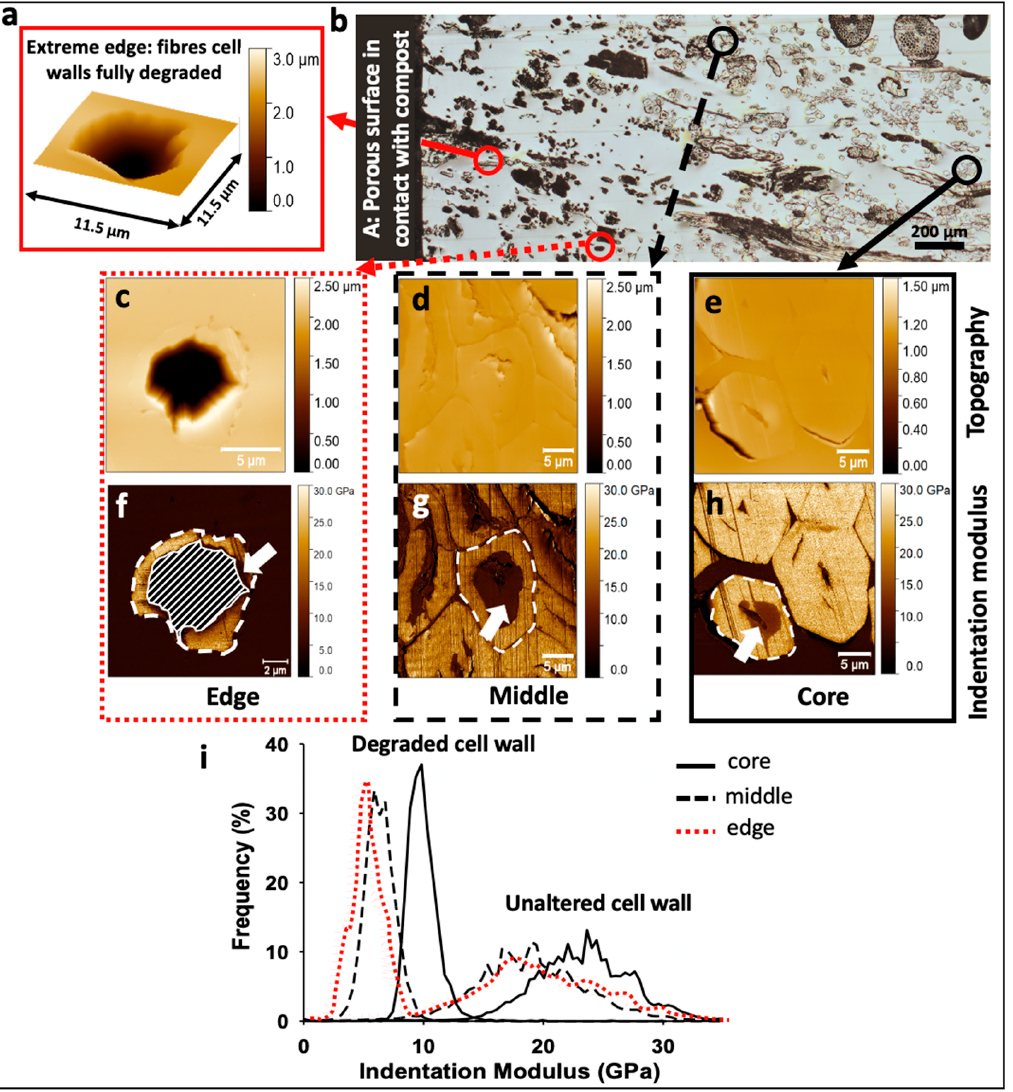
Figure 4. ( a ) 3D AFM topographic image of a fully degraded fibre, located at the extreme edge of the sample; ( b ) face C investigated through AFM-PF-QNM; black and red circles indicate the fibres selected for AFM measurements; ( c – e ) are AFM topographic images of edge, middle and core areas, respectively, and ( f – h ) the corresponding indentation modulus maps. ( i ) shows the indentation modulus distribution for each investigated region, indicated in white dotted lines in ( f – h ). In ( f ), no data were recorded in the hatched area.